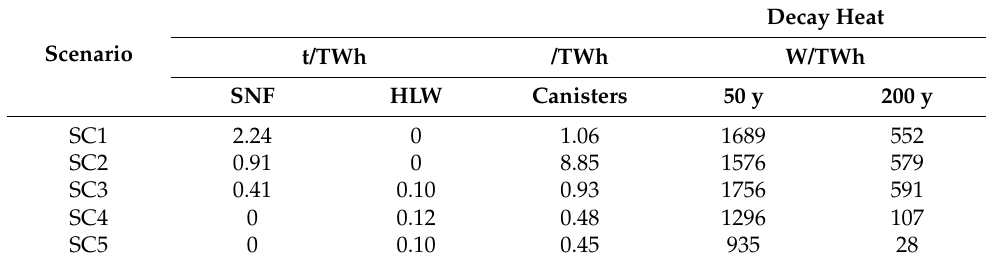
Table 8. Key results from Dungan et al.